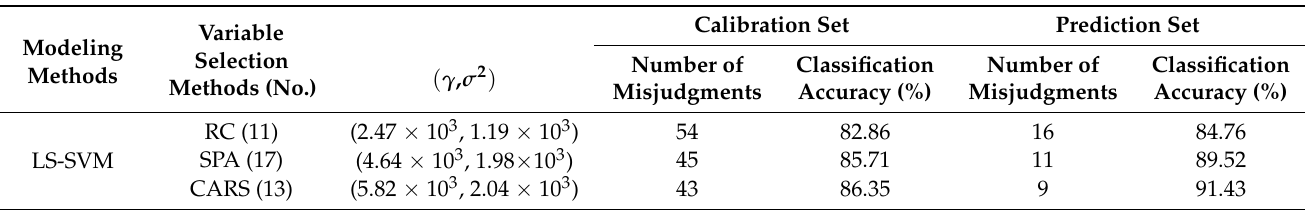
Table 3. Effects of discriminant models based on different characteristic wavelength methods.